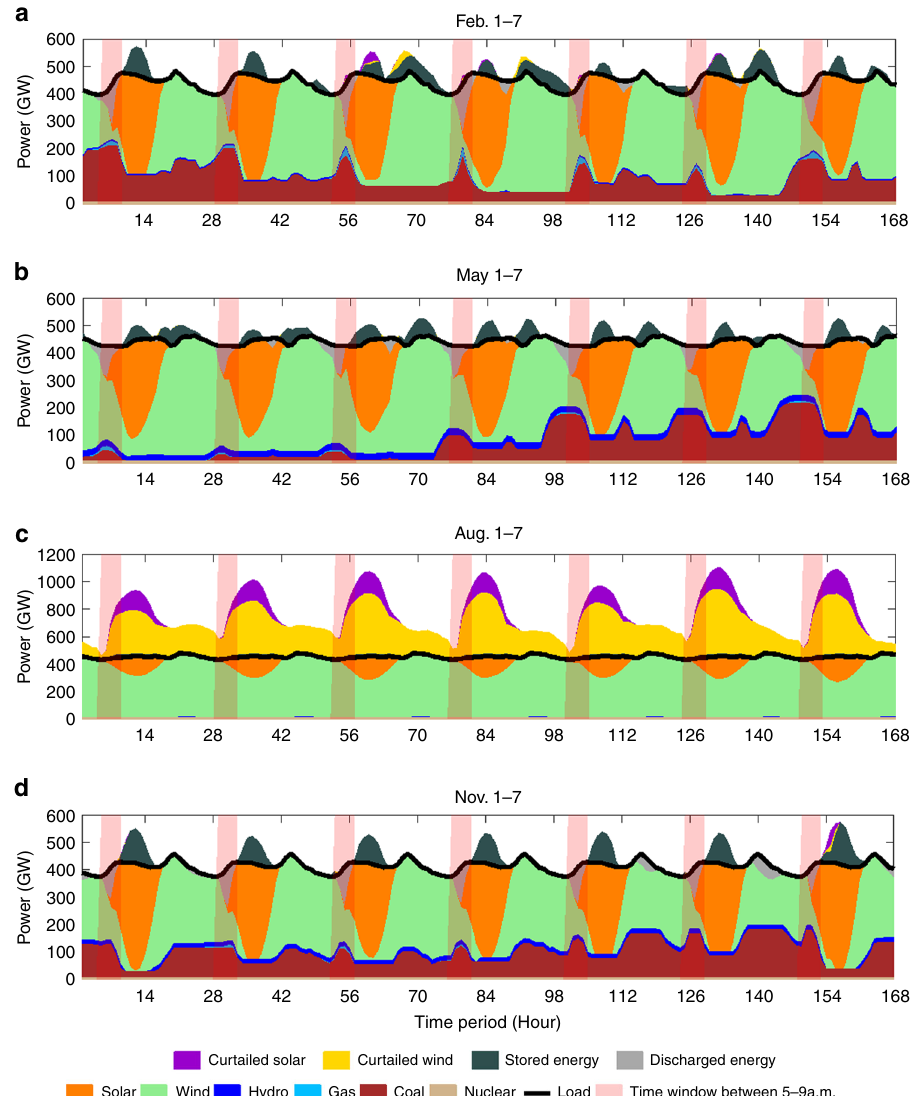
Fig. 7 Seasonal hourly power balance. Hourly power balances de fi ned for – seasonally representative weeks on the basis of the 80% renewables standard model simulation: February 1 – 7 ( a ), May 1 – 7 ( b ), August 1 – 7 ( c ), and November 1 – 7 ( d